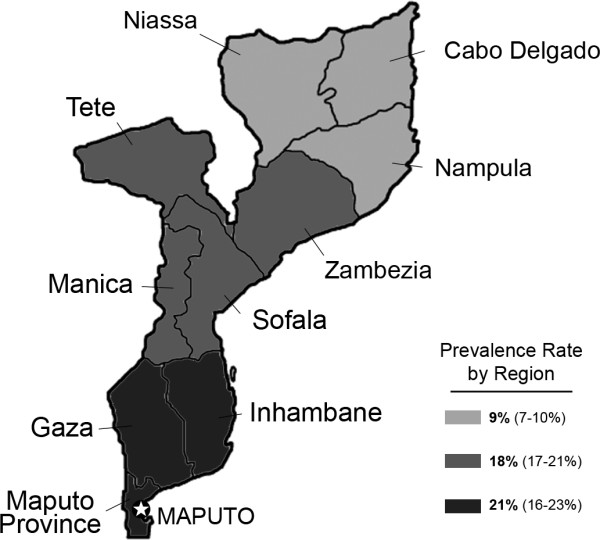
Map of Mozambique highlighting regional prevalence rates.